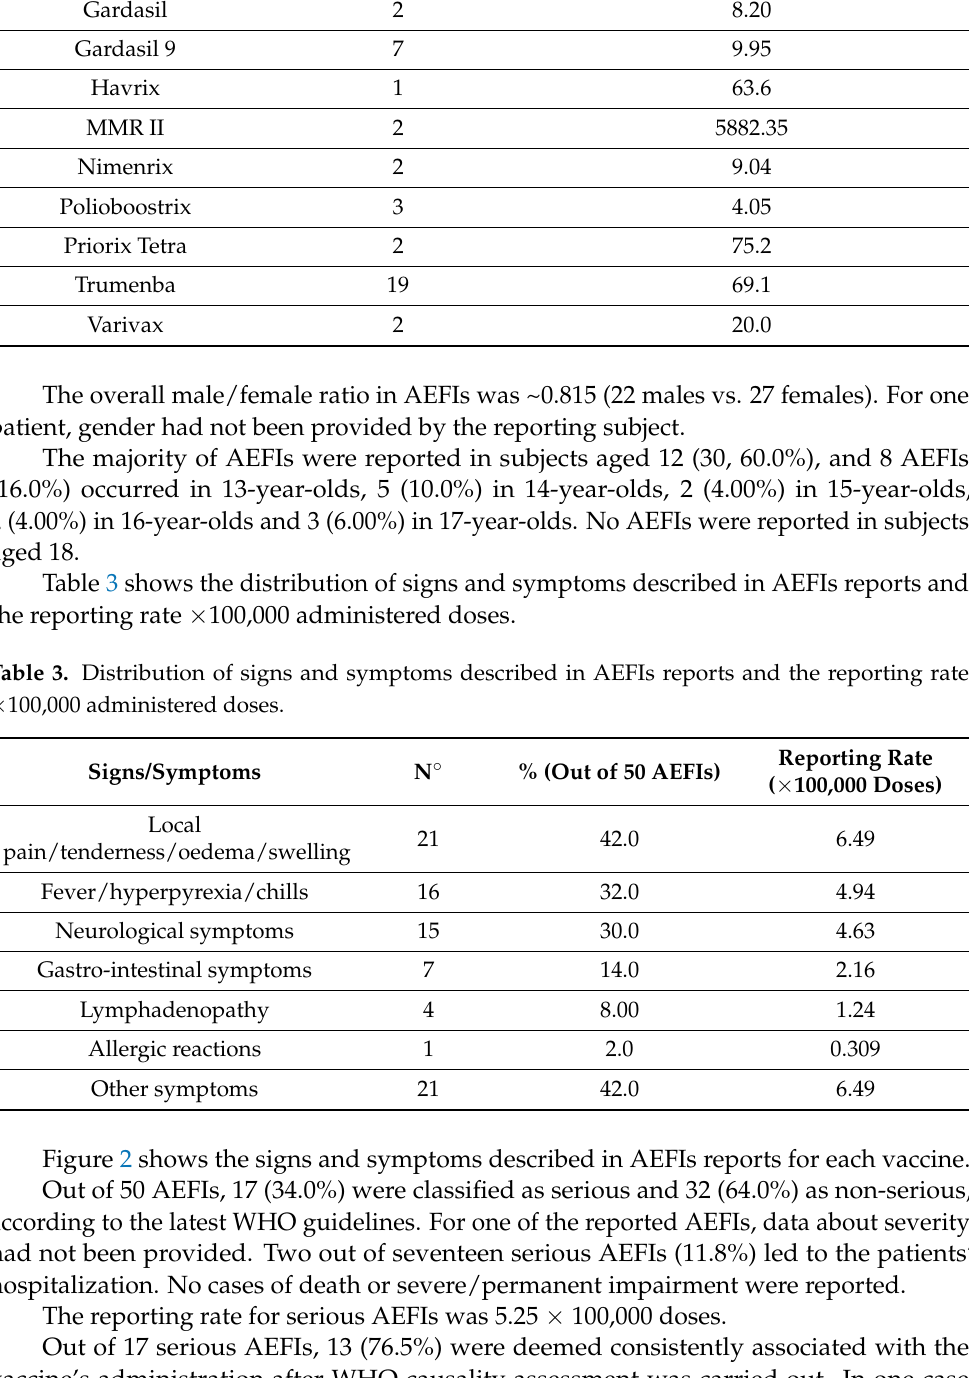
Table 2. Reporting rates of AEFIs in subjects aged 12–18 from 2016 to 2020, divided per vaccine. Vaccine Number of AEFIs Reporting Rate ( × 100,000 Doses) Bexsero